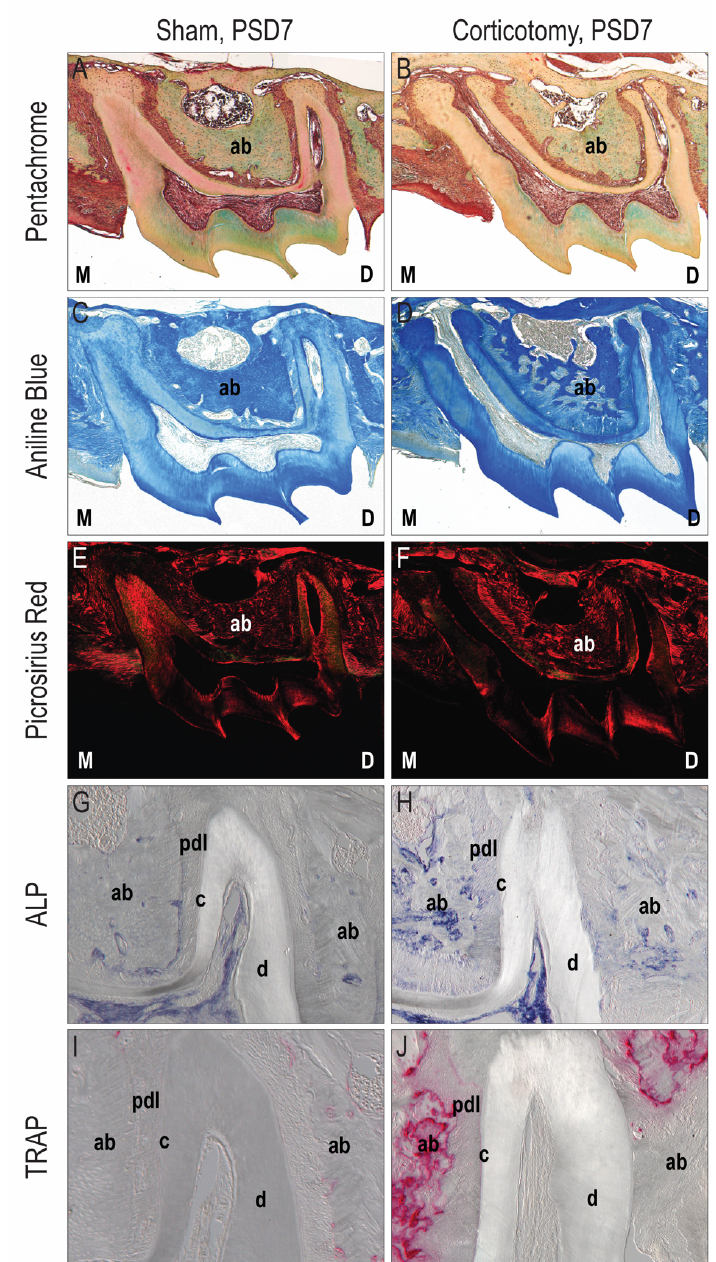
Figure 1. Histological sections from the maxillary first molar on PSD 7 ( n = 12). ( A ) Tissue sections stained with Movat’s pentachrome after sham operation and ( B ) corticotomy. (Elastic Fibers: Black to Blue/Black; Nuclei: Blue/Black; Collagen: Yellow; Reticular Fibers: Yellow; Mucin: Bright Blue; Fibrin: Bright Red; Muscle: Red.) ( C ) Aniline blue staining to detect a new osteoid matrix after sham operation and ( D ) corticotomy. ( E ) Tissues stained with picrosirius red after sham operation and ( F ) corticotomy. Representative sagittal sections captured from the distal root of M1. ( G ) Tissue sections stained with ALP to detect mineralized activity after sham operation and ( H ) corticotomy. ( I ) Tissue sections stained with TRAP to detect osteoclast activity after sham operation and ( J ) corticotomy. Abbreviations: PSD: post-surgery day; M: mesial; D: distal; pdl: periodontal ligament; ab: alveolar bone; d: dentin; c: cementum. Scale bar = 100 μm ( A – F ). Scale bar = 50 μm ( G – J ).